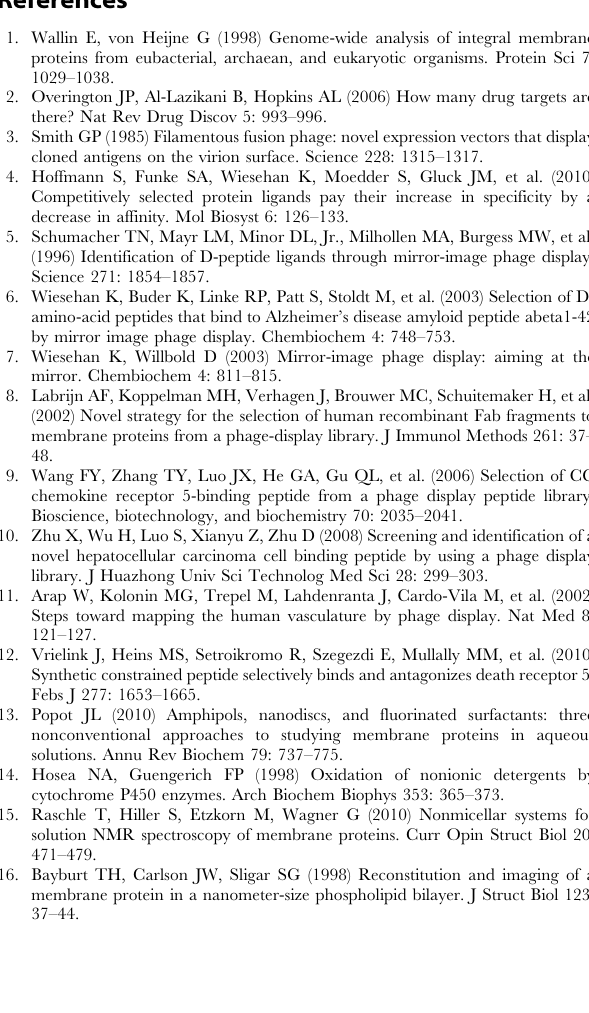
Table S1 Multiple sequence alignment of all peptides sequences exposed by bR binding